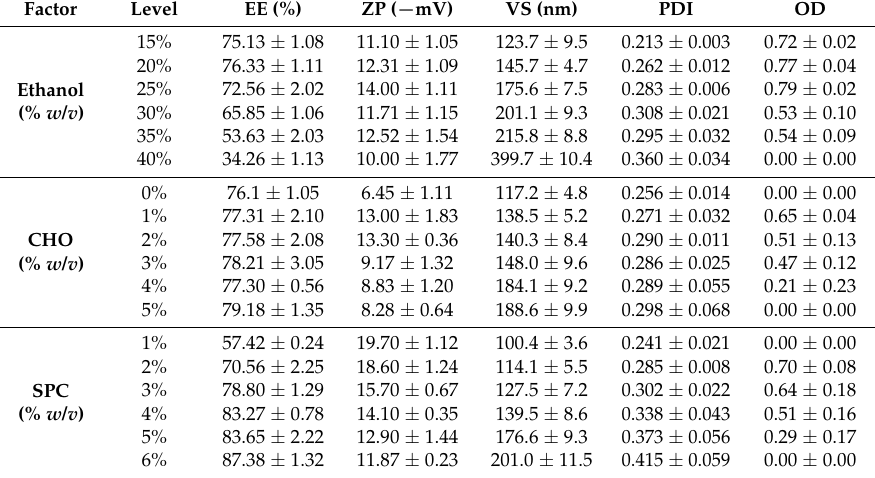
Table 1. Arrangement and determination results of single-factor test (mean ± SD, n =